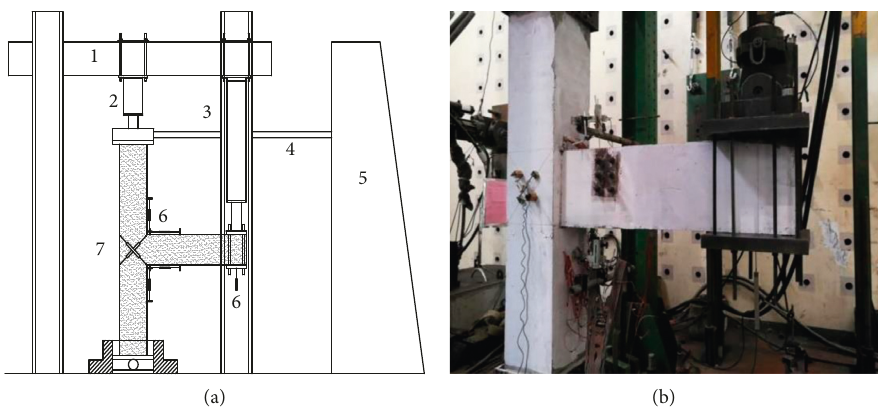
Figure 4: Experimental setup. (a) Schematic diagram (1, reaction beam; 2, jack; 3, actuator; 4, horizontal bracing; 5, reaction wall; 6, displacement meter; 7, extensometer). (b) Photo.